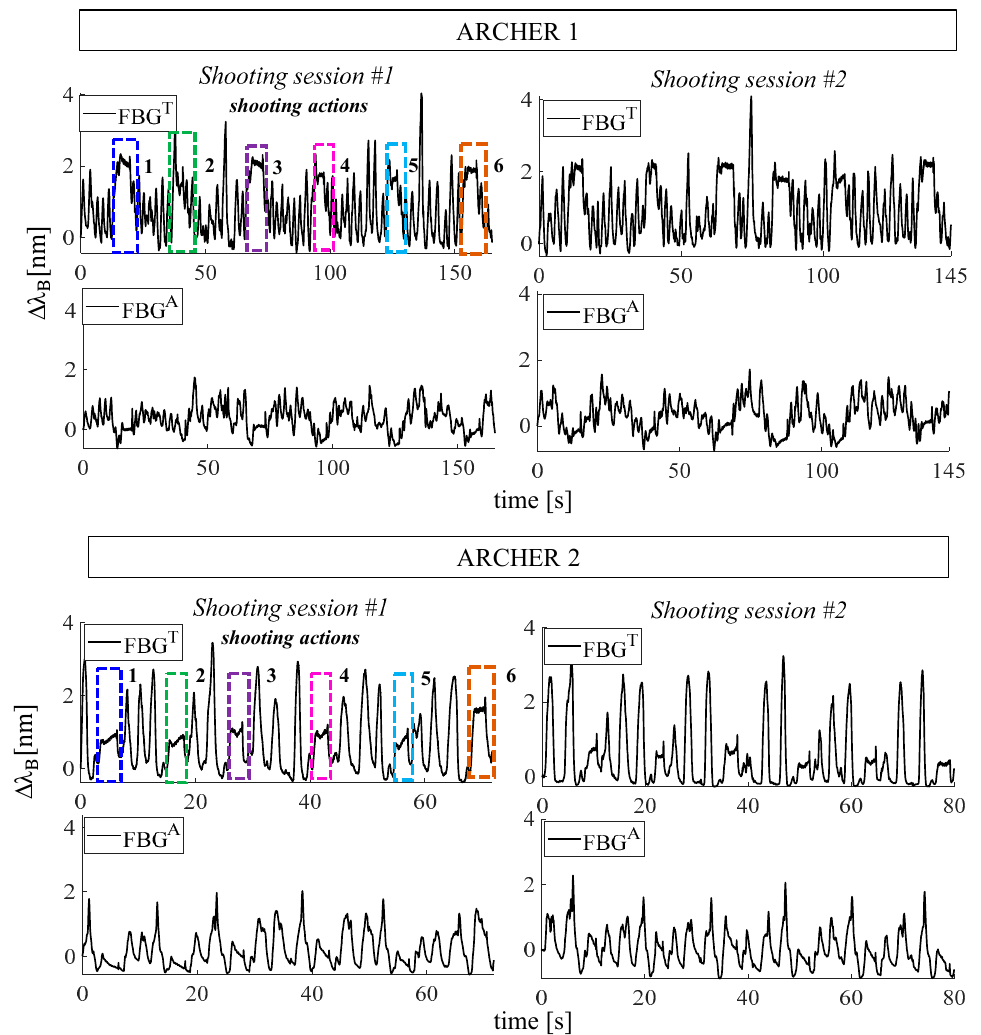
Figure 10. Outputs of the two flexible FBG sensors are shown for the four trials (2 shooting sessions for each archer). By way of example, the shooting actions of the first session are highlighted by dashed rectangular boxes.